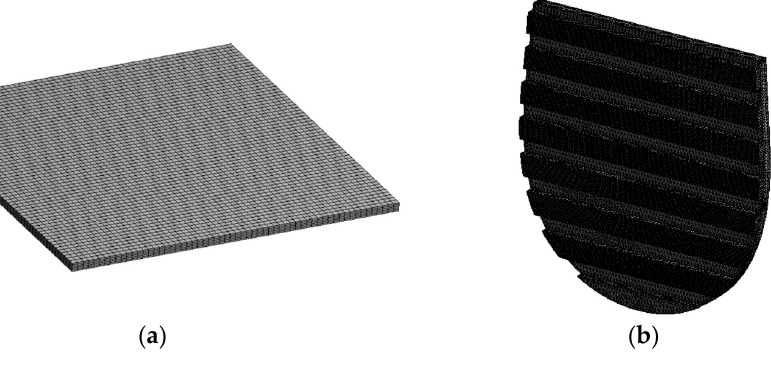
Figure 4. The generated meshes for: ( a ) surface and ( b ) outsole.